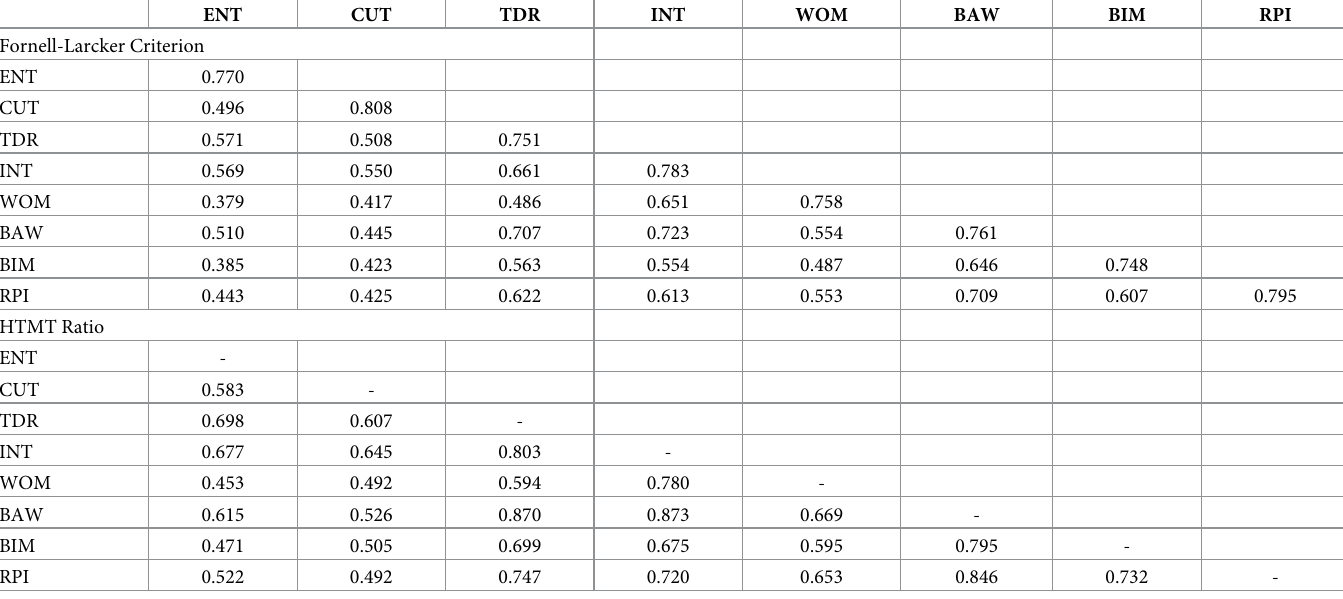
Table 4. Discriminant validity